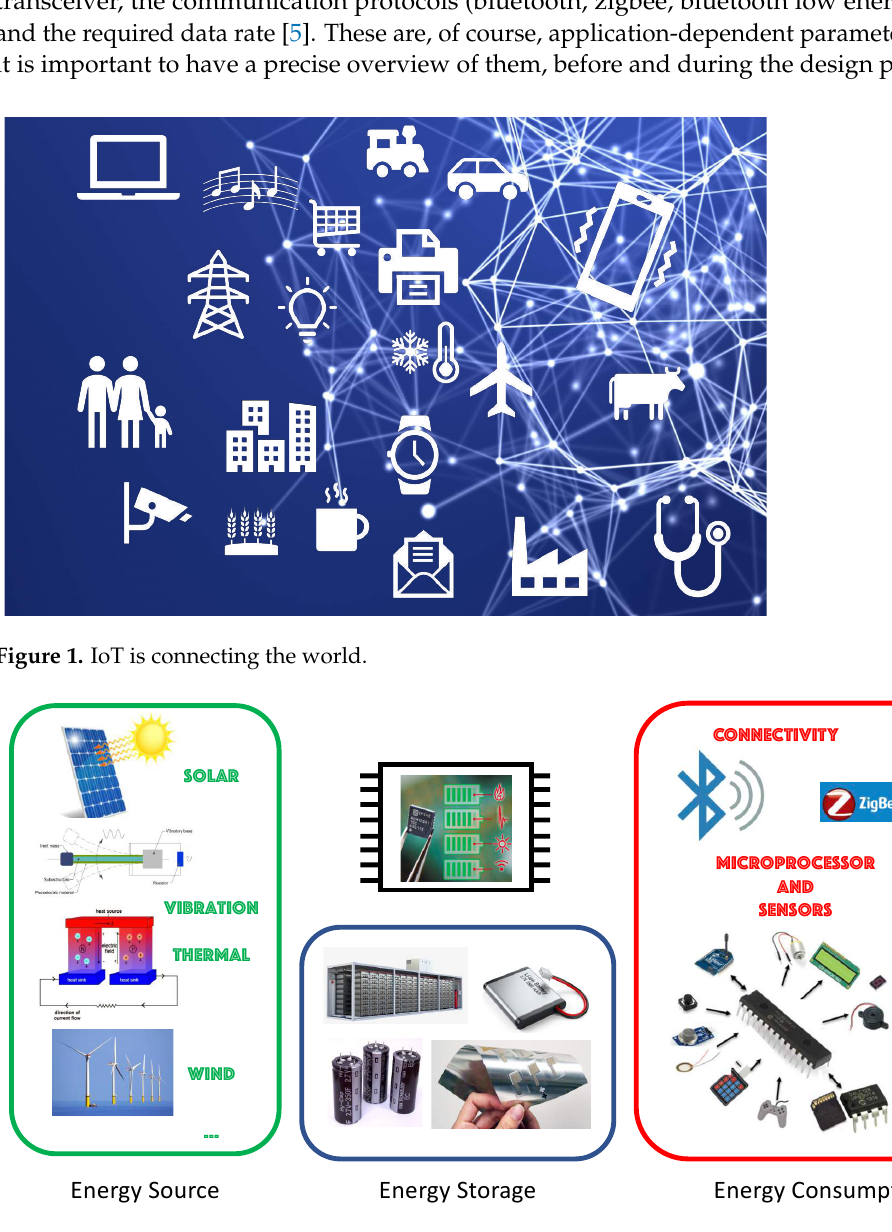
Figure 2. The energy in IoT